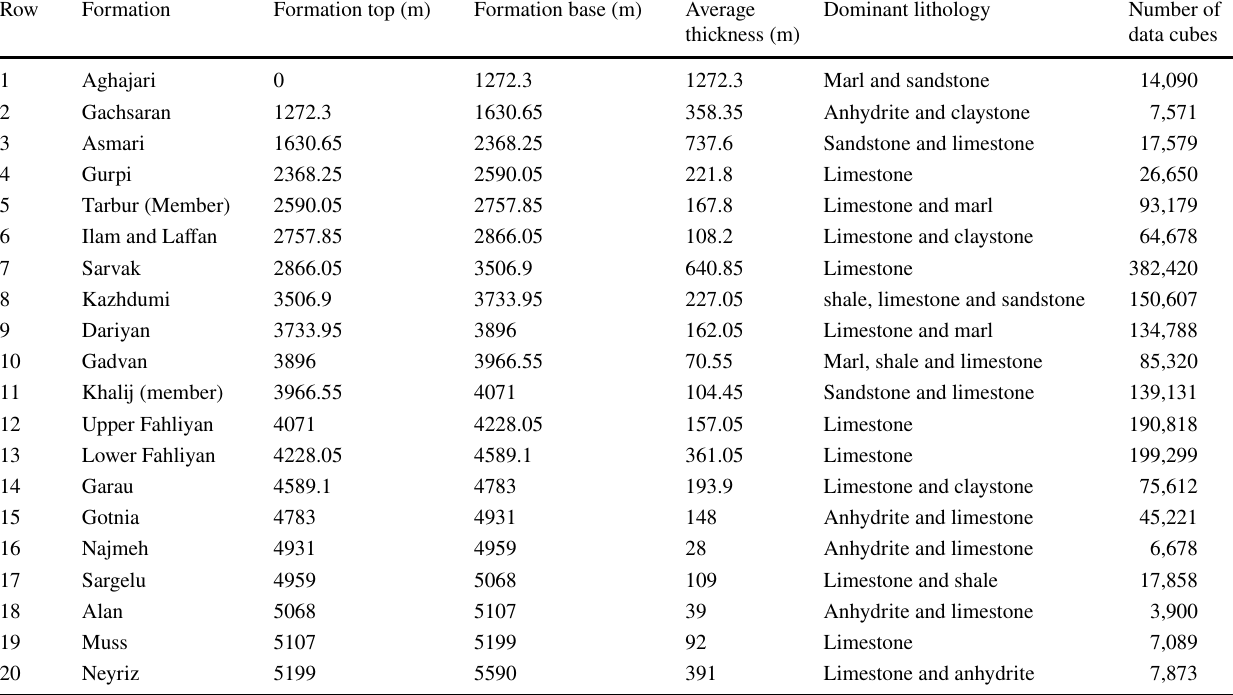
Fig. 3 Sample of seismic data section with formation top, depth domain seismic sections, and location of exploratory wells in South Azadegan Field (Kianoush et al. 2022) Table 1 Division of South Azadegan Field based on the average cubic thickness of geological layers (using Petrel 2016